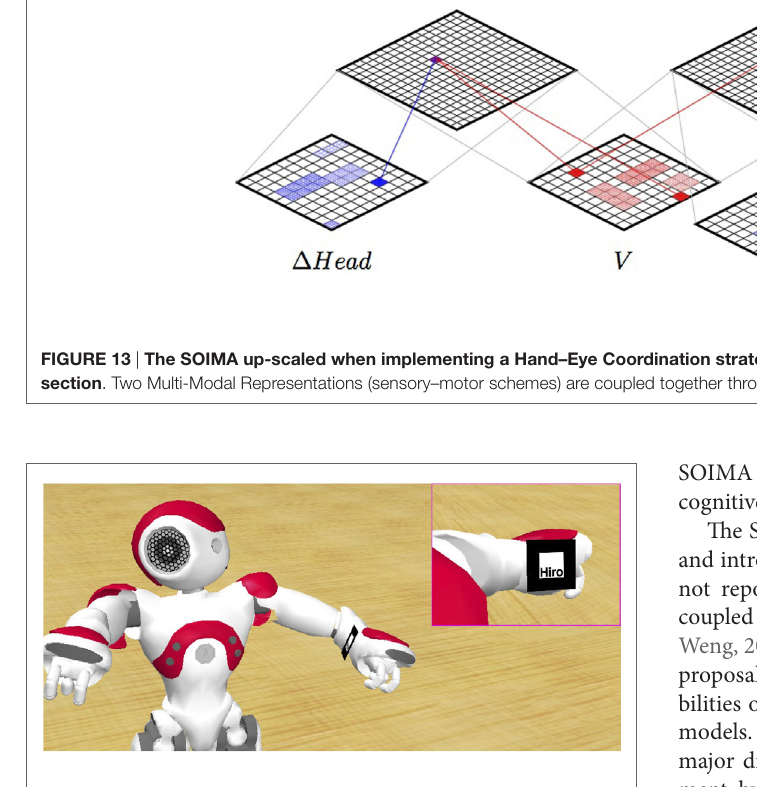
FigUre 14 | hand–eye coordination task experimental setup . Given particular arm and hand postures of the robot, the system provides a head posture such that the hand appears in the visual